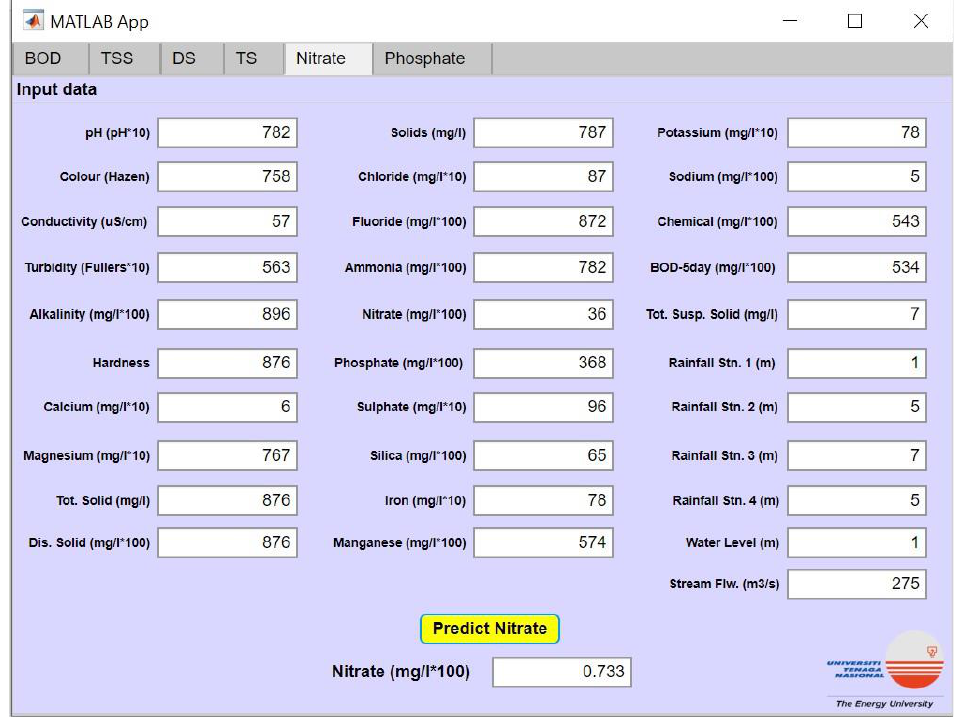
Figure 7. The app developed based on real-time data.